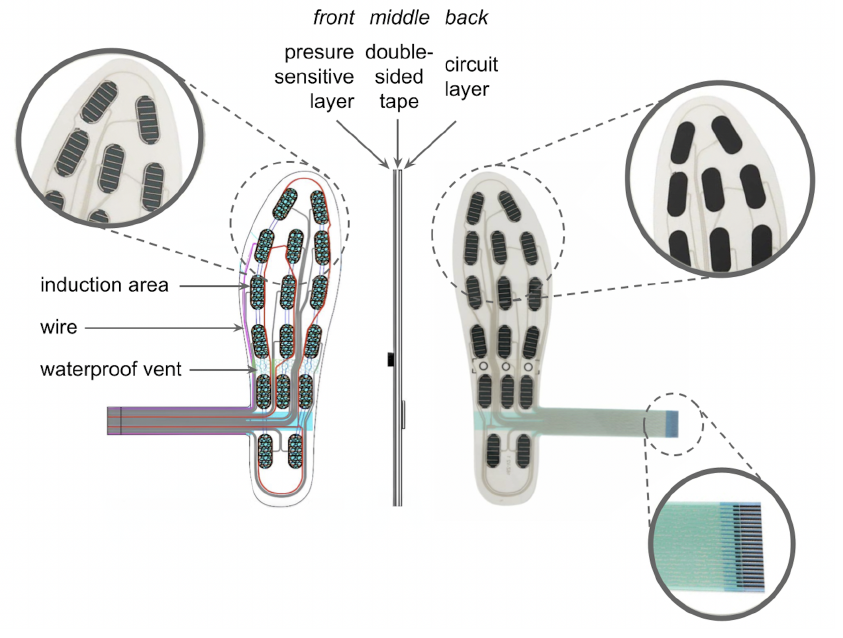
Figure 3. Electronic insole